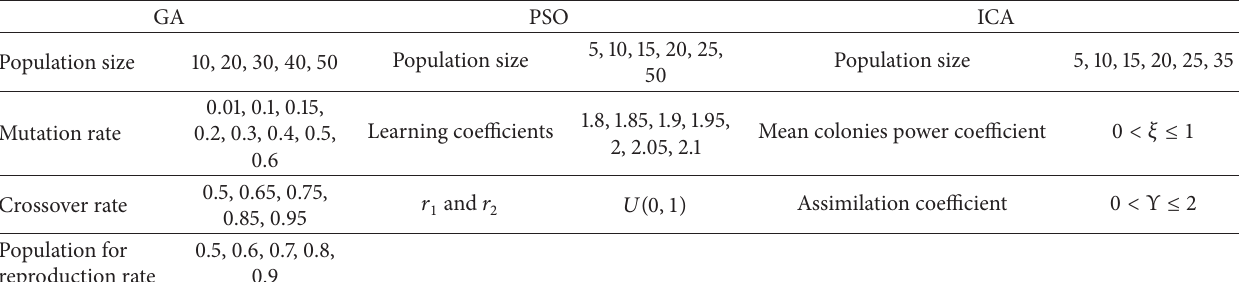
Table 1: Different parameters values used for testing.